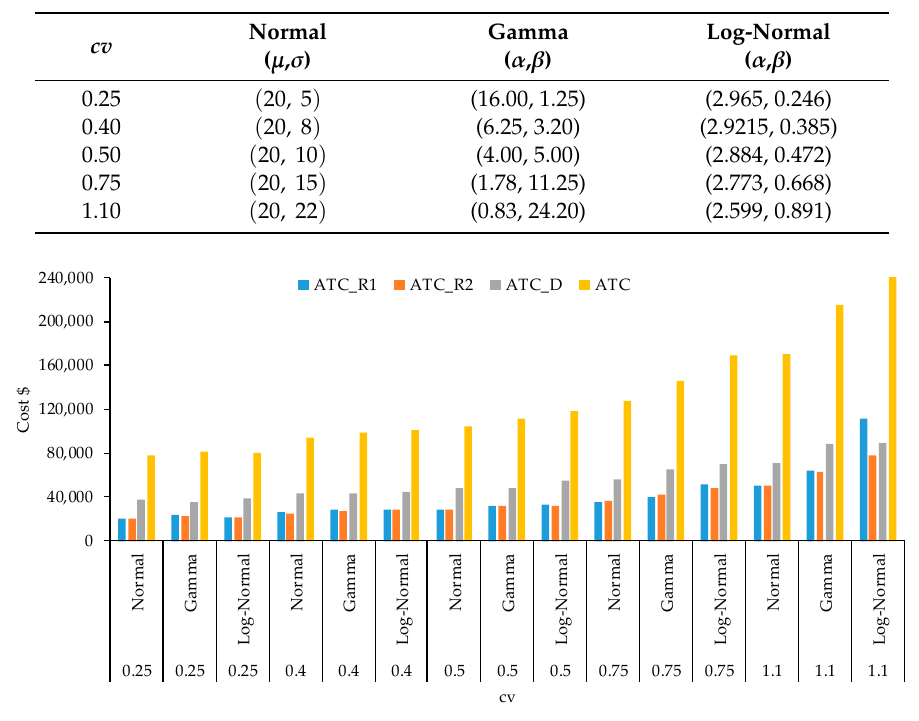
Figure 4. ATC of R1, R2, and DC with normal, gamma, and log-normal distribution of daily demand.